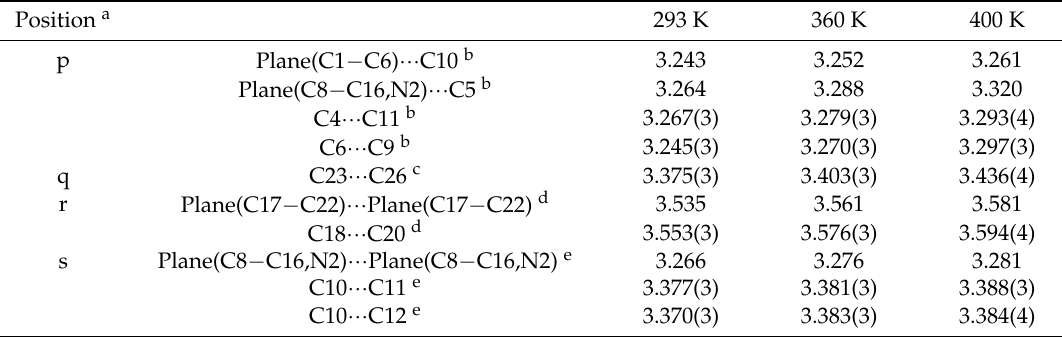
Table 6. Selected intermolecular short distances (Å) at 293, 360, and 400 K in 1 . Position a 293